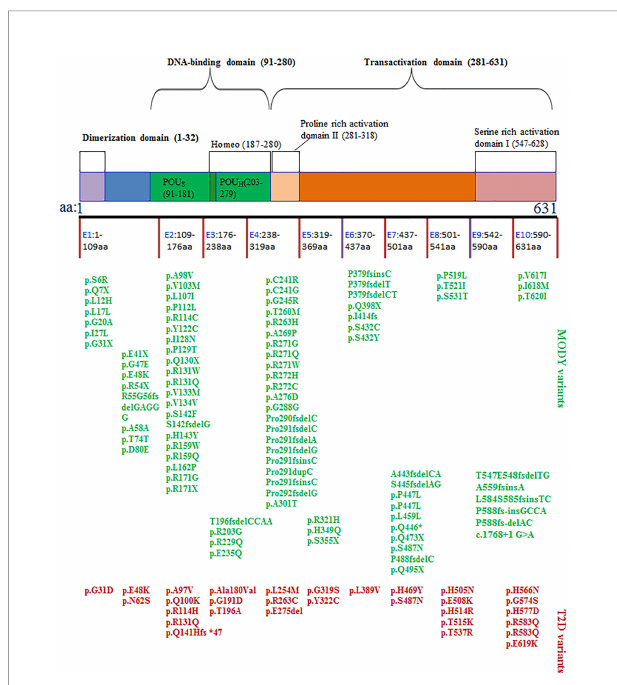
FIGURE 1 | The structure of HNF1 a protein and the SNPs associated with MODY3 or T2D. The SNPs in blue often cause MODY3. The SNPs in red often cause